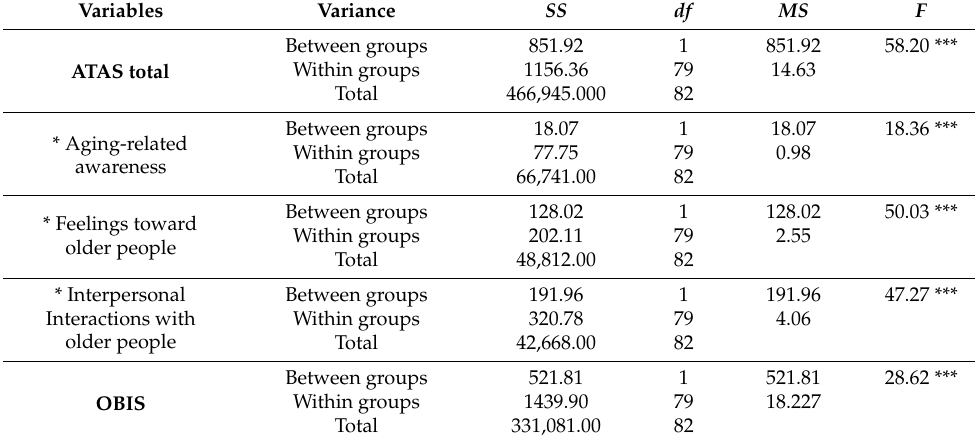
Table 4. One-way ANCOVA analysis.